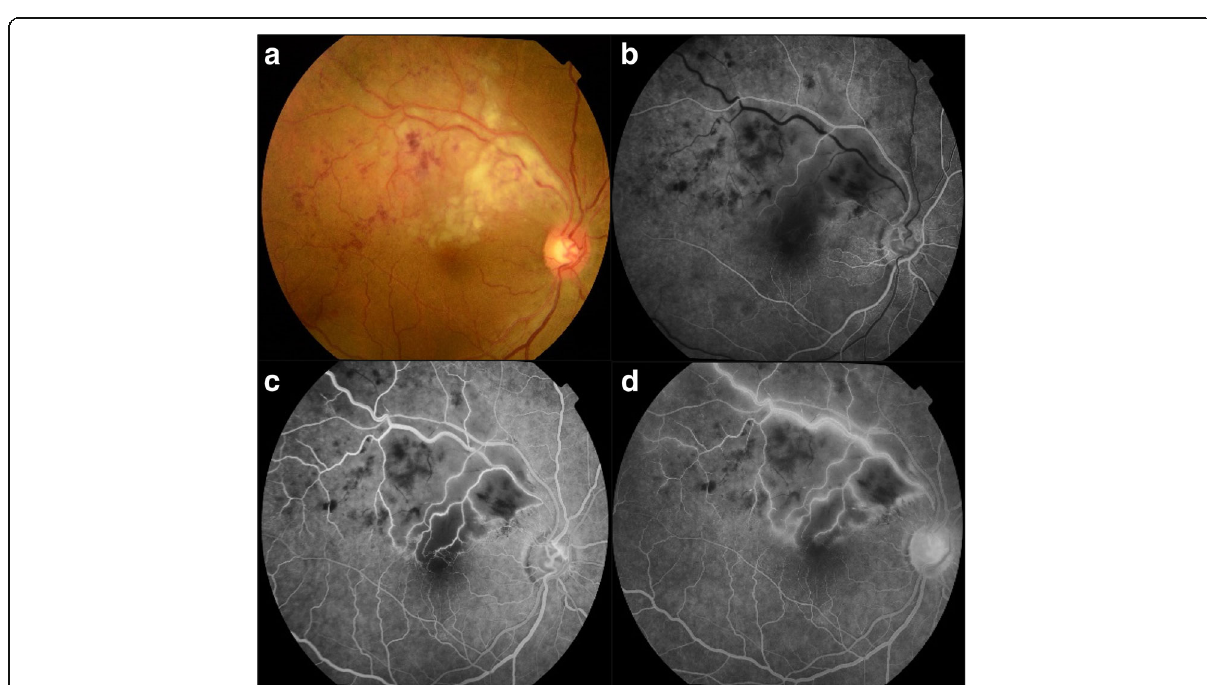
Fig. 1 a Fundus picture of the right eye showing multiple intra-retinal hemorrhages, venous tortuosity, and dilatation along with retinitis patch (approximately 2 DD) in the superotemporal quadrant. b FFA early phase showing hypofluorescence with masking due to intra-retinal hemorrhages and delayed venous filling in the superotemporal quadrant. c Mid-phase showing hyperfluorescence along the vessel walls with capillary dropout areas. d Late phase showing marked hyperfluorescence along the vessel